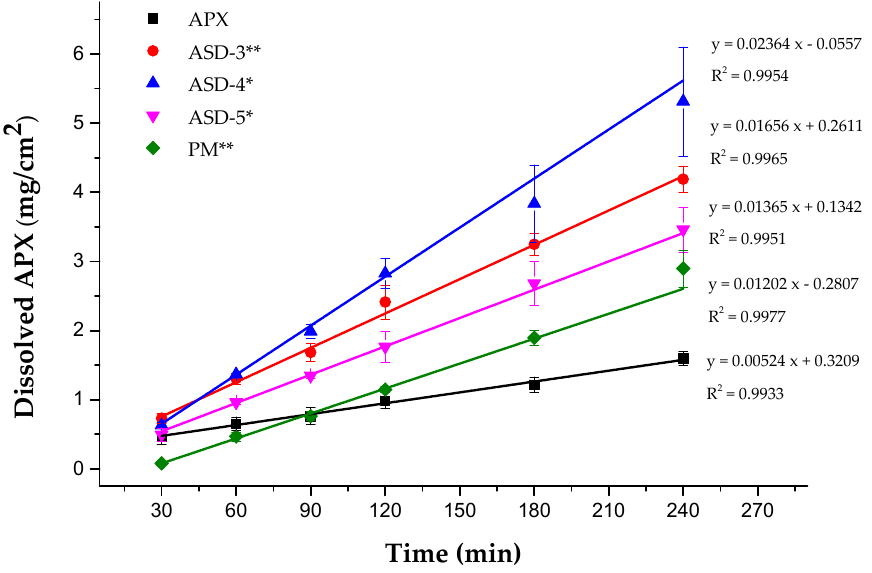
Figure 3. PXRD pattern of APX, Soluplus ® , PM, and ASD − 3,4,5. Figure 4. PXRD pattern of APX, Soluplus